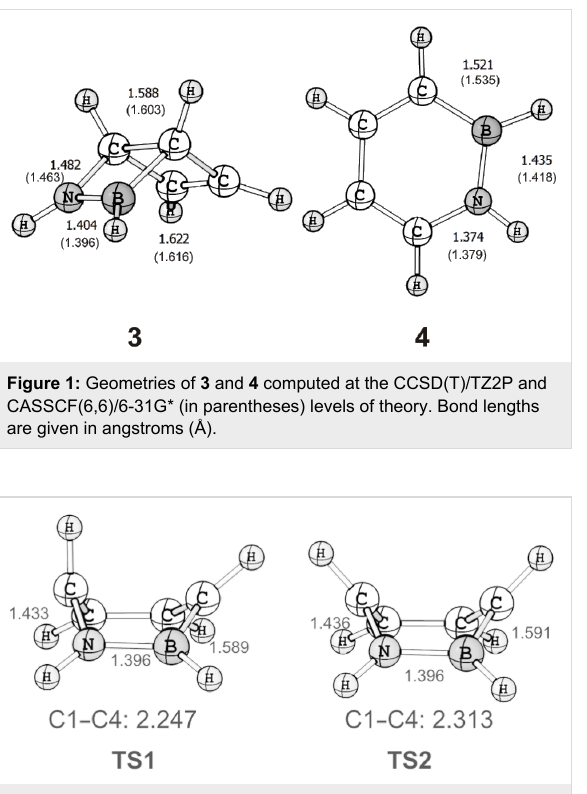
Figure 2: Geometries of TS1 and TS2 computed at the CASSCF(6,6)/ 6-31G* level of theory. C1–N, N–B, C4–B, and C1–C4 distances are given in angstroms